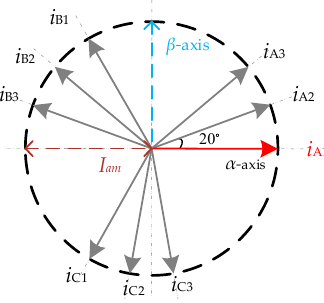
Figure 3. The standard Clark